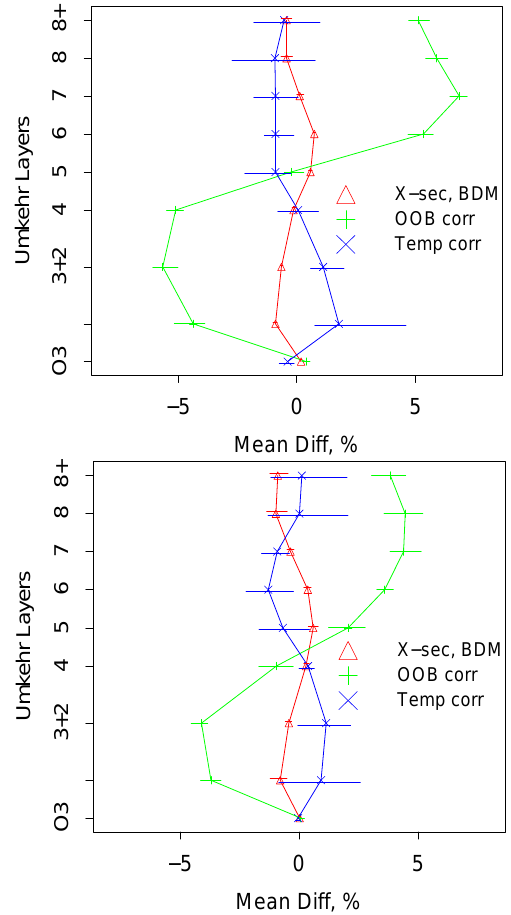
Fig. 8. (a) The same as in Fig. 4, but results are averaged for the EC Brewer Umkehr time series collected at MLO, Hawaii, between 1998 and 2005. (b) The same as in Fig. 6, but results are averaged for the NEUBrew Umkehr ozone profile time series collected by Brewer #141 at Table Mountain Test Facility, near Boulder, Col- orado, between 14 August 2006 and 20 October